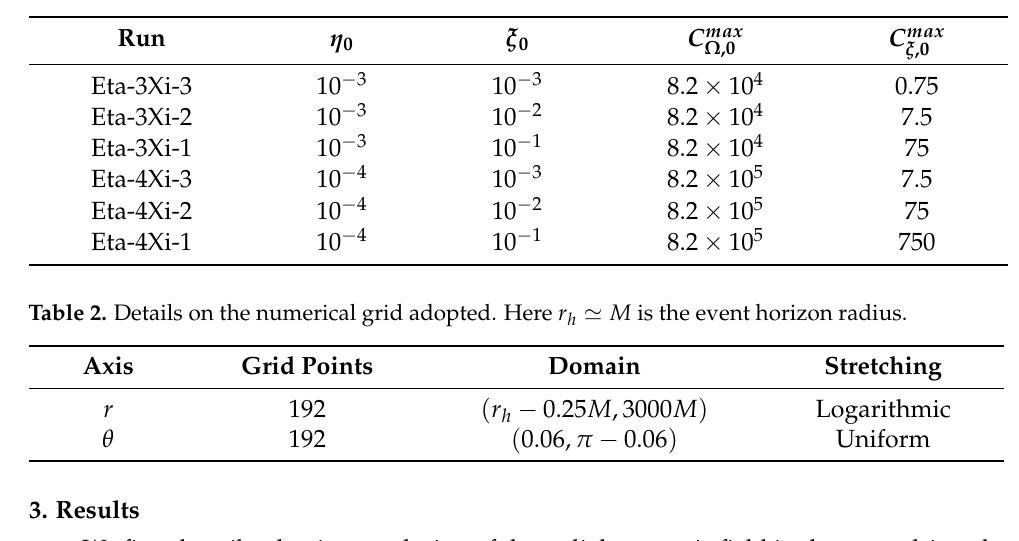
Table 1. Maximum initial values of η , ξ , C Ω , and C ξ for each model.